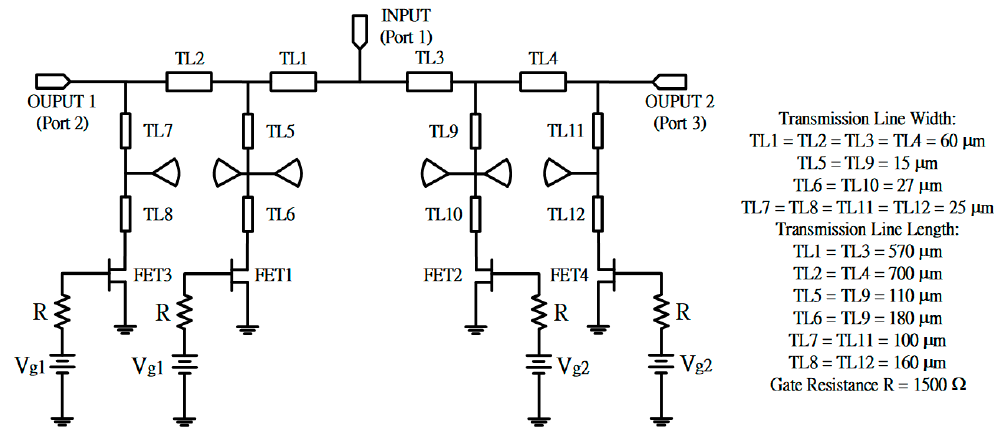
Figure 10. The complete schematic of the proposed SPDT switch with radial stub implemented in the impedance transform network.